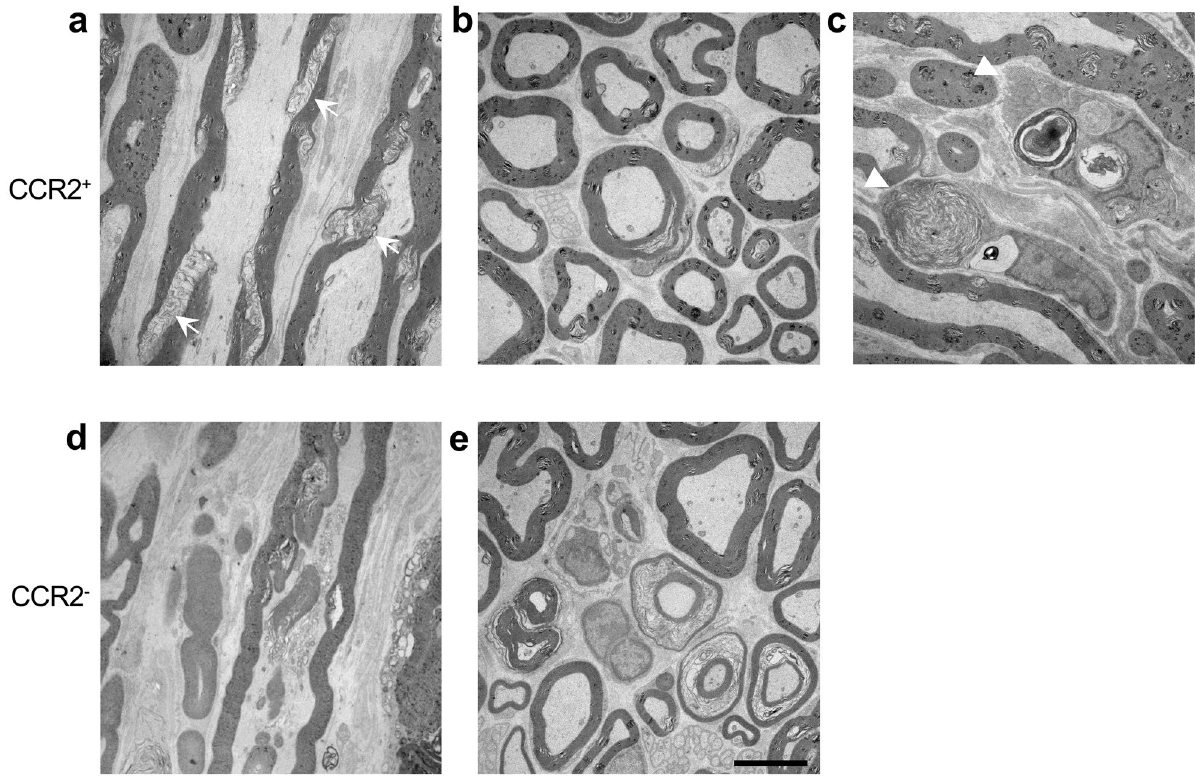
Figure 6. Electron microscopic findings of the sciatic nerve. ( a ) The longitudinal section of the sciatic nerve from a CCR2-positive SOD1 G93A mouse at 12 weeks of age shows preserved axonal structure and some derangement of the Schmidt-Lanterman incisures (arrow). ( b ) Cross-section of the sciatic nerve from a CCR2-positive SOD1 G93A mouse at 20 weeks of age with relatively preserved axons and some vesiculation of the myelin sheath. ( c ) Foamy macrophages containing cell and myelin debris are visible adjacent to the axons in the longitudinal section of the sciatic nerve from a CCR2-positive SOD1 G93A mouse at 12 weeks of age (arrowhead). ( d ) Longitudinal section of the sciatic nerve from a CCR2-deficient SOD1 G93A mouse at 12 weeks of age with disruption of intra-axonal structures. ( e ) Cross-section of the sciatic nerve from a CCR2-deficient SOD1 G93A mouse at 20 weeks of age with many disrupted, shrunken axons and marked vesiculation of the myelin sheath. Scale bar: 5 and expressed Arg-1, an M2 marker, but not iNOS, an M1 marker, in the peripheral nerves was also observed. These findings suggest that CCR2 + macrophages recruited into the peripheral nerves from the blood exert neuroprotective functions on the lower motor neurons in mSOD1 ALS and that the clearance of abnormal mSOD1 protein from peripheral nerves by these cells is a hitherto underestimated host protective mechanism (Supplementary Fig. 6). The SOD1 G93A / CCR2 RFP/WT / CX3CR1 GFP/WT mice started to deteriorate at 12 weeks of age and died at 21 weeks of age, which is similar to the reported clinical course of mSOD1 G93A ALS mice 22 . In the SOD1 G93A / CCR2 RFP/WT / CX3CR1 GFP/WT mice, we observed that mSOD1 accumulated in the peripheral nerves much earlier (4 weeks of age) than in the spinal cord (12 weeks of age), which is in accord with a previous report describing the earlier accumulation of mSOD1 protein in the sciatic nerve compared with the lumbar spinal cord (2.6-fold increase in the sciatic nerve vs. 1.8-fold increase in the lumbar cord at 30 days of age compared with at birth, and remaining consistently higher in the sciatic nerve than in the lumbar cord until 120 days of age) 22 . These observations support distal axonopathy as a primary mechanism of the lower motor neuron death in mSOD1 ALS 6,25 . We also confirmed the accumulation of mSOD1 in the DRG and, to a lesser extent, in the dorsal roots as previously reported, which explains the sensory system involvement observed in mSOD1 ALS patients and model animals 26 . Because DRGs are bipolar cells, we hypothesized that mutant protein transported by an afferent mechanism is not cleared in CNS regions where there is no or little peripheral macrophage infiltration, unlike the sciatic nerve, which harbors high numbers of peripheral macrophages. It was suggested that there may be differences in the characteristics of axonal transport between motor and sensory neurons in the SOD1 mouse model related to differences in dynein and dynactin functions 27 . In line with the earlier accumulation of mSOD1 protein in the peripheral nerves, we found increased CX3CR1 + macrophages infiltration into the sciatic nerve as early as 4 weeks of age and the subsequent infiltration of CX3CR1 + CCR2 + macrophages at 8 weeks of age. CX3CR1 + macrophages, which were observed at 4 weeks of age, are considered resident macrophages, whereas CX3CR1 + CCR2 + macrophages are thought to be peripheral blood-borne macrophages. CCR2 single positive cells are considered peripheral blood-derived immune cells,